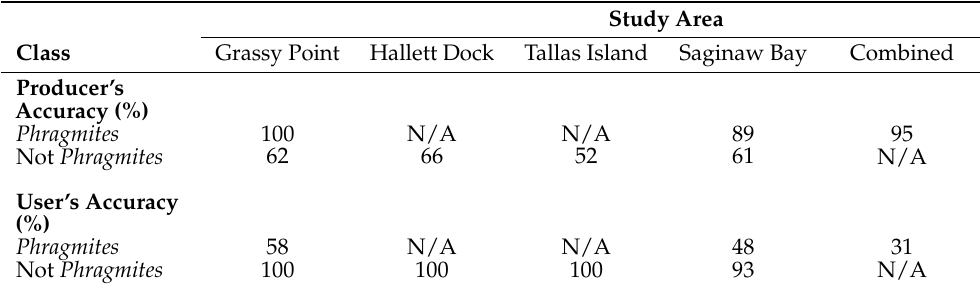
Table 6. Classification performance for all four study sites when using the RGB UAS imagery without the use of a CHM or RADARSAT-2 HH polarization. Producer’s accuracy and user’s accuracy are provided for each study site. Only the accuracy of the Not Phragmites class was calculated for Hallett Dock and Tallas Island. The combined accuracy of the Not Phragmites class was not calculated. Study Area Class Grassy Point Hallett Dock Tallas Island Saginaw Bay Combined